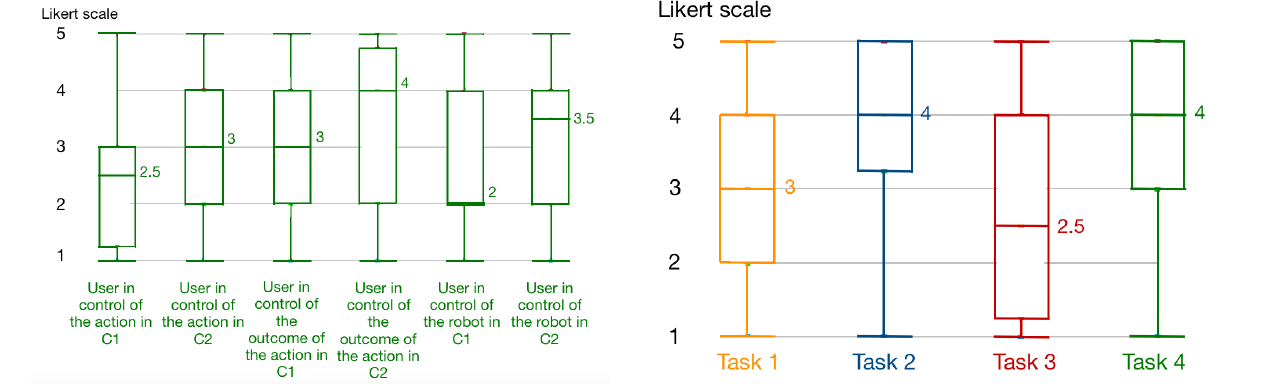
Figure 18: Task criticality